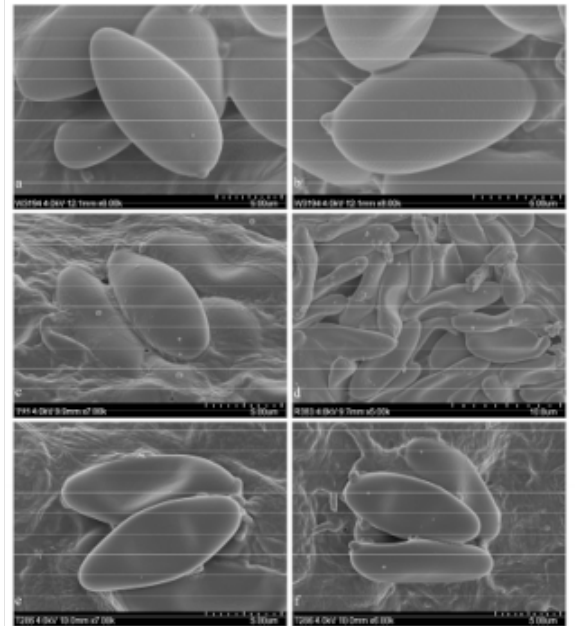
Figure 7. Basidiospores observed in the SEM. ( a , b ) Suillellus lacrymibasidiatus ; ( c ) Butyriboletus sub- regius ; ( d ) Butyriboletus pseudoroseoflavus ; ( e , f ) Tengioboletus subglutinosus . Butyriboletus subregius Yang Wang, Bo Zhang & Yu Li, sp.